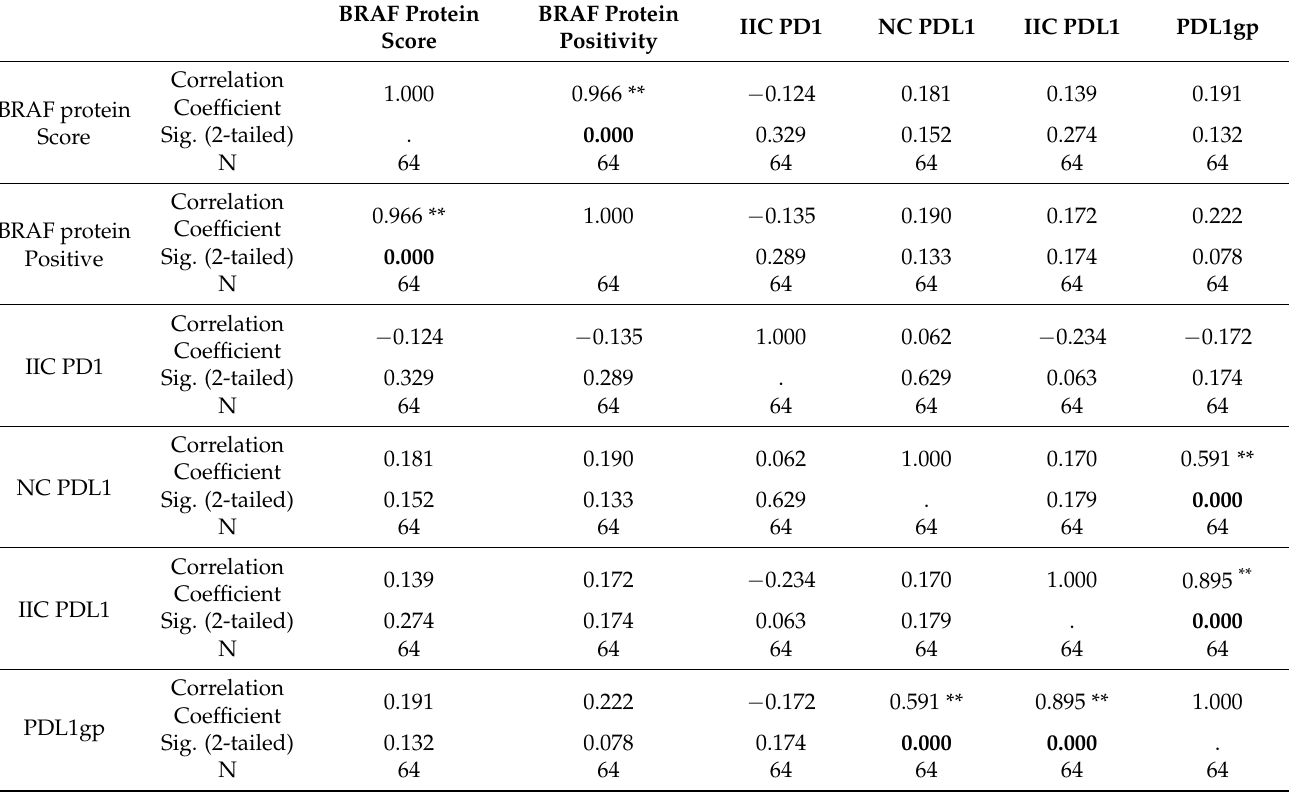
Table 5. Correlation between IIC PD1, NC PDL1, IIC PDL1, combined PDL1, and BRAF